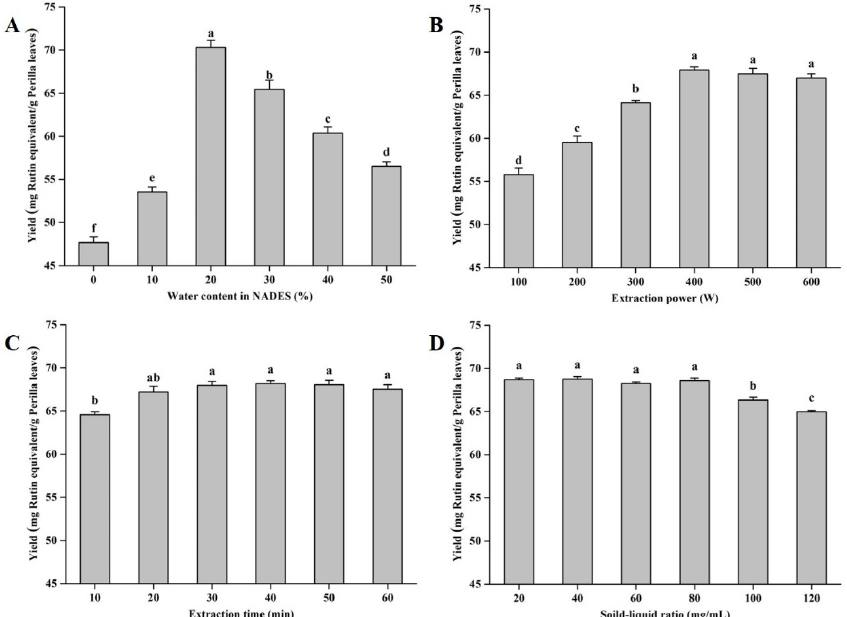
Figure 3. The extraction yields of total flavonoids from perilla leaves with different influencing factors. Invariant extraction conditions: 300 W, 20 min, and 100 mg/mL ( A ); 30%, 20 min, and 100 mg/mL ( B ); 30%, 300 W, and 100 mg/mL ( C ); and 30%, 300 W, and 20 min ( D ). Data sharing the different letters were significantly different ( p < 0.05). Table 2. The results of Box–Behnken design for NADES-MAE